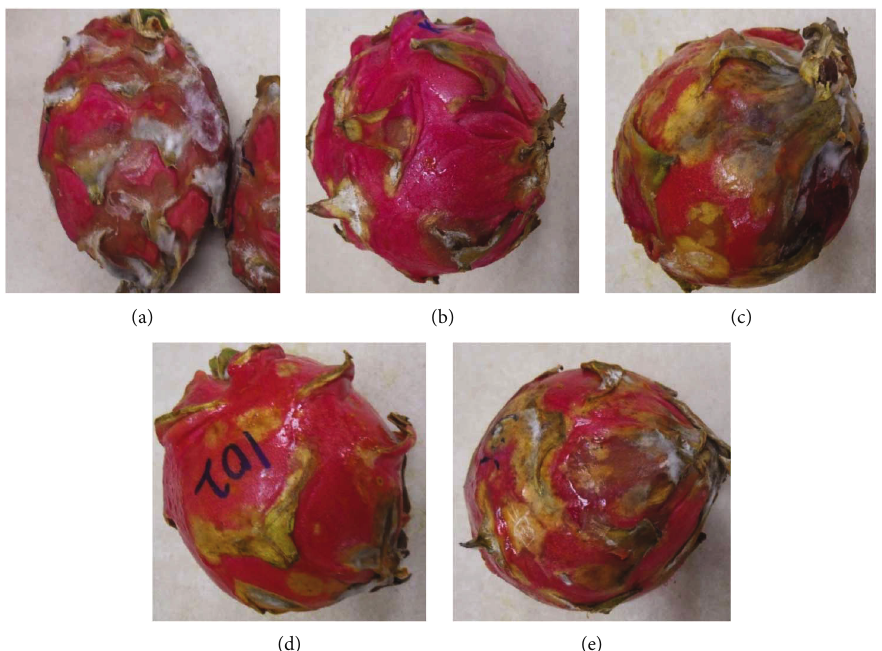
Figure 2: E ff ect of 10% GA incorporated with turmeric extract at di ff erent concentrations (g L -1 ) on disease incidence and severity of dragon fruit after 28 days of storage. (a) Control, (b) fungicide (mancozeb-2gL -1 ), (c) 10% GA+5gL -1 , (d) 10% GA+10g L -1 , and (e) 10% GA +15gL -1